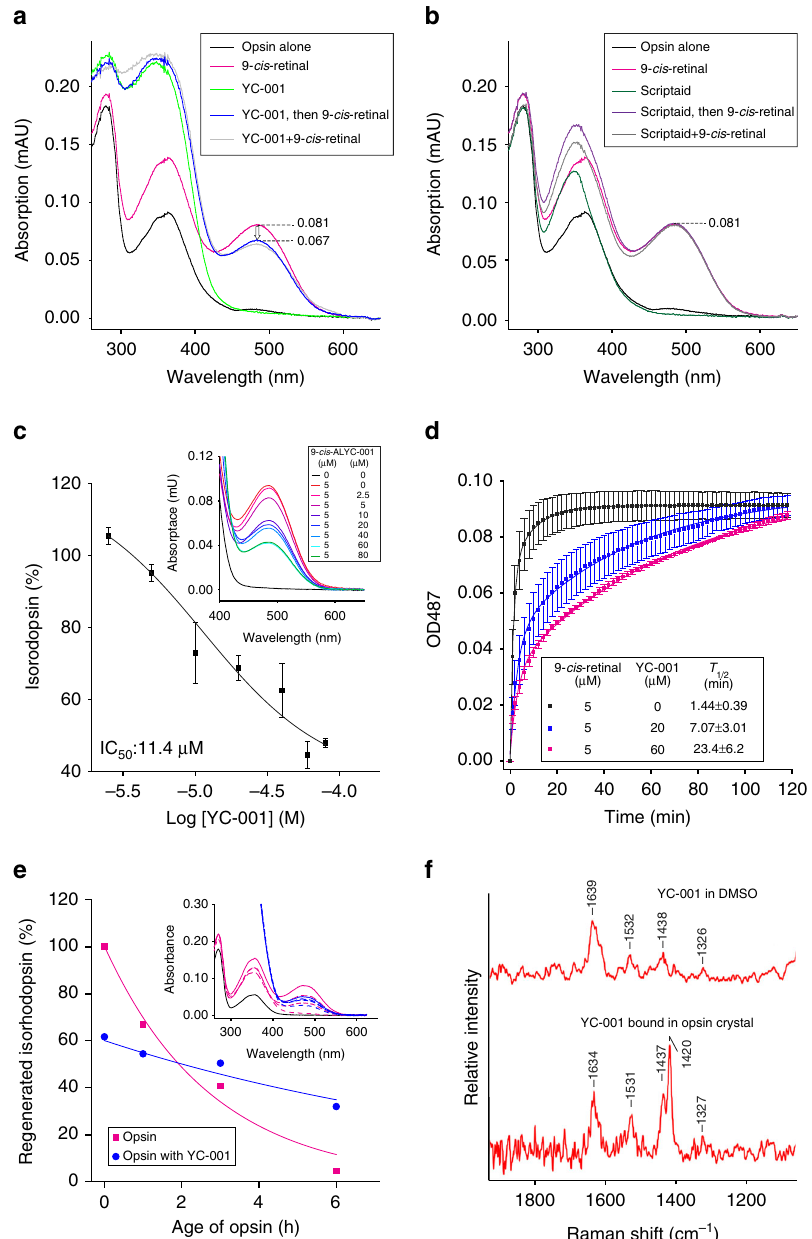
Fig. 4 YC-001 delays isorhodopsin pigment regeneration. Bovine opsin (2.5 µ M) in ROS membranes was incubated with compounds (20 µ M) for 30 min at RT. After membrane solubilization, absorbance at 487nm was recorded to measure the amount of isorhodopsin. a UV – visible absorption spectra of opsin (black) and opsin treated with 9- cis -retinal (magenta), YC-001 (light green), YC-001 followed by 9- cis -retinal for 15 min each (blue), and a mixture of YC- 001 and 9- cis -retinal (gray). b UV – visible absorption spectra of opsin treated with 9- cis -retinal (magenta), scriptaid (dark green), scriptaid followed by 9- cis -retinal for 15 min each (purple), and a mixture of 9- cis -retinal and scriptaid (gray). c Percentage of regenerated isorhodopsin from sequential treatment with YC-001 and 9- cis -retinal for 15 min each as a function of YC-001 concentration in a log format. Isorhodopsin regenerated with 9- cis -retinal alone was normalized as 100%. Values and error bars were averages and s.d.s from three biological replicates. Inset, absorption spectra of opsin with 5 μ M 9- cis - retinal and 0 (red), 2.5 (pink), 5 (magenta), 10 (purple), 20 (dark blue), 40 (cyan), 60 (light blue), or 80 μ M YC-001 (green), respectively. d Time course of isorhodopsin regeneration in the presence of 0, 20, or 60 μ M YC-001 followed by addition 5 μ M 9- cis -retinal for 15 min each (black, blue, and magenta boxes, respectively). Values and error bars were averages and s.d.s of three biological repeats. Data were fi tted with second-order exponential decay and apparent half-lives ( T 1/2 ± standard error) are shown in the inset box. e Percentage of regenerated isorhodopsin from aged opsin (magenta) or opsin incubated with YC-001 (blue) at RT for 0, 1, 3, and 6 h before regeneration with 9- cis -retinal. Isorhodopsin regenerated from opsin at 0 h was set at 100%. Plots of regenerated isorhodopsin levels were fi tted by the exponential decay function. The inset shows the absorption spectra of regenerated isorhodopsin from aged opsins. Black, opsin alone. f Raman spectrum of YC-001 in DMSO solution (top) and a difference spectrum after subtracting the spectrum of rod opsin crystal from that of opsin crystal soaked with YC-001 (bottom). Each experiment was repeated